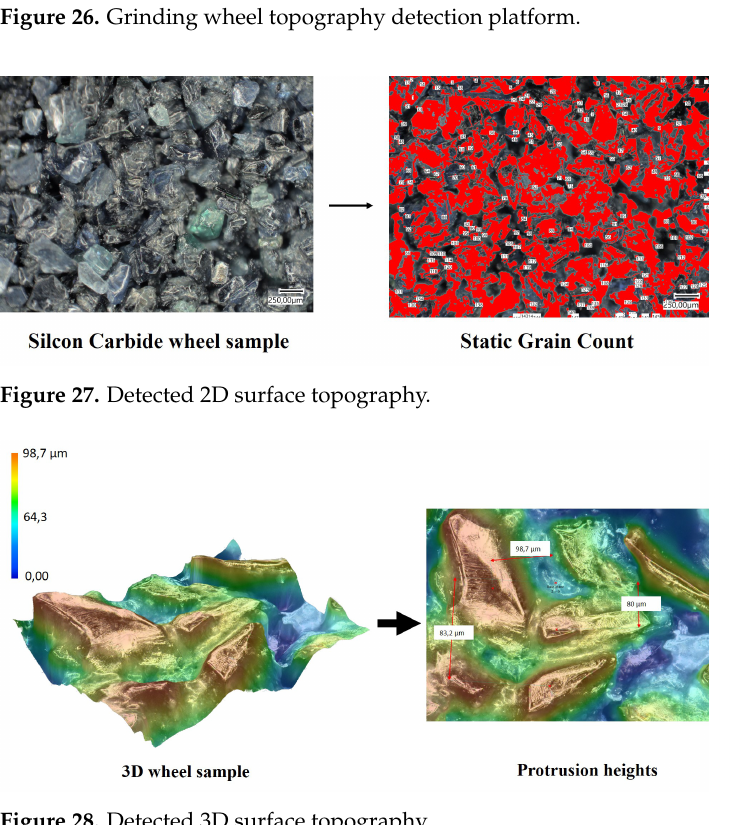
Figure 28. Detected 3D surface